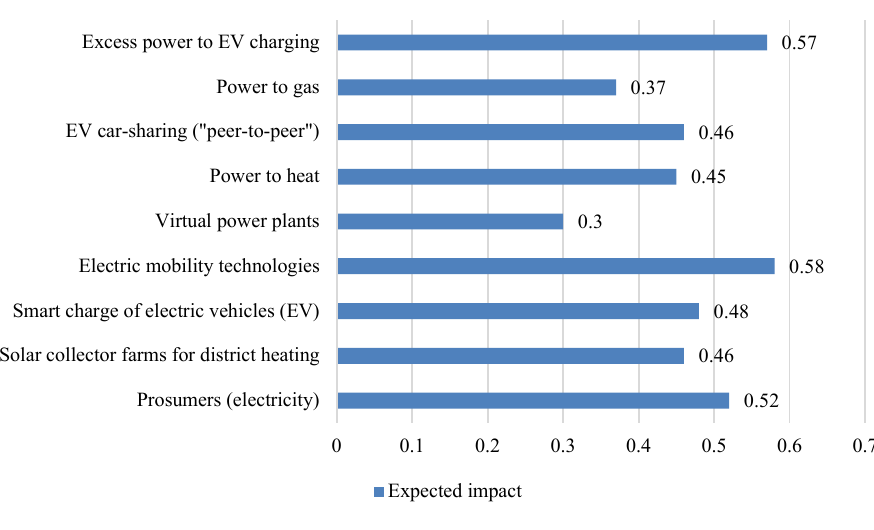
Fig. 2. Expected Impact of on scale 0–1 of business models with highest score in